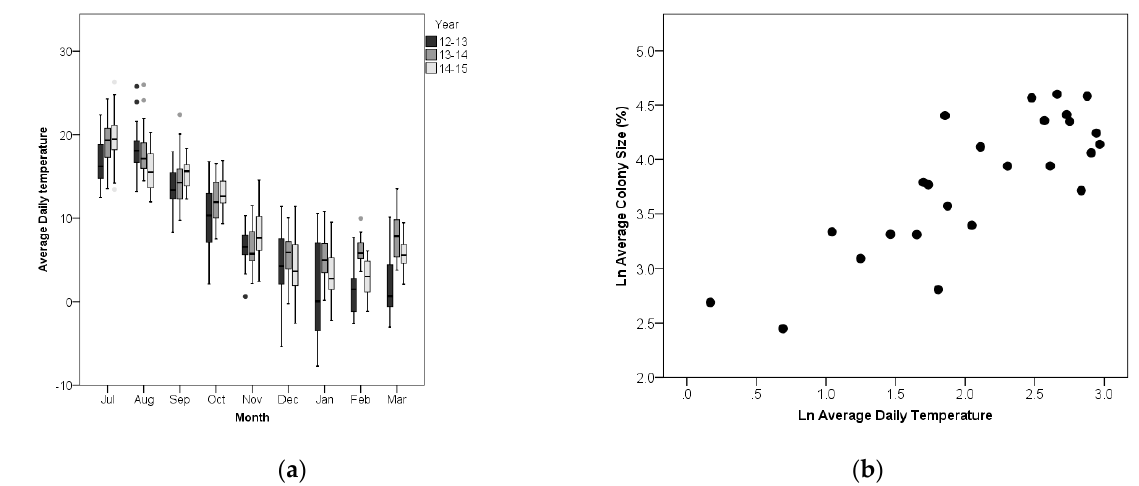
Figure 3. Average daily temperature (°C) per month for 2012, 2013, and 2014 ( a ) and its relationship with the average colony size per month (%) ( b ). In panel ( b ), the Ln-transformed data are shown.